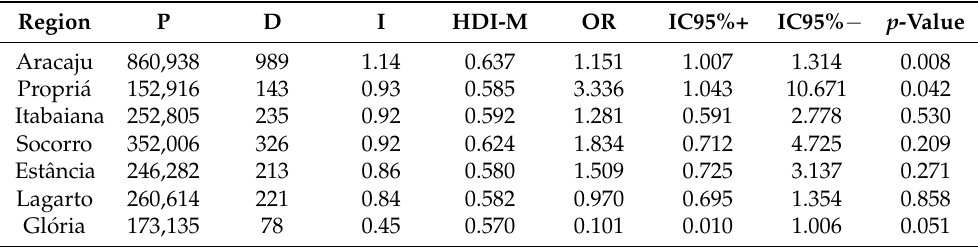
Table 4. Relationship between incidence of deaths by COVID-19 and HDI of health regions in